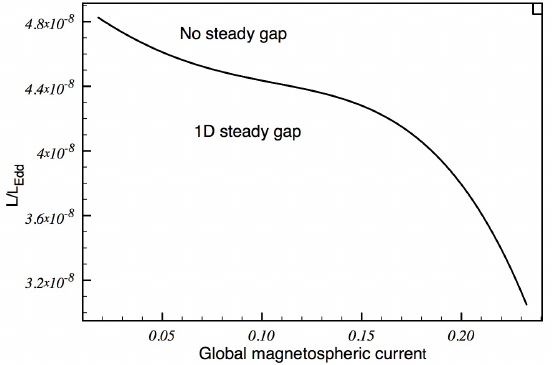
Figure 8. Maximum Eddington ratio below which local steady gap solutions exist, versus normalized magnetospheric current, 2 π J 0 / ( Σ null Ω B H cos θ ) , where Σ null is the value of Σ on the null surface, for a supermassive black hole of mass M BH = 10 9 M (cid:12) , magnetic field B = 10 4 G, a radiation source of size R = 30 r g and a power law spectrum, I ν ∝ ν − 2 , with a low energy cutoff at ν min = 10 12 Hz, and inclination angle θ = 30 ◦ . (See Ref. [113] for further details).